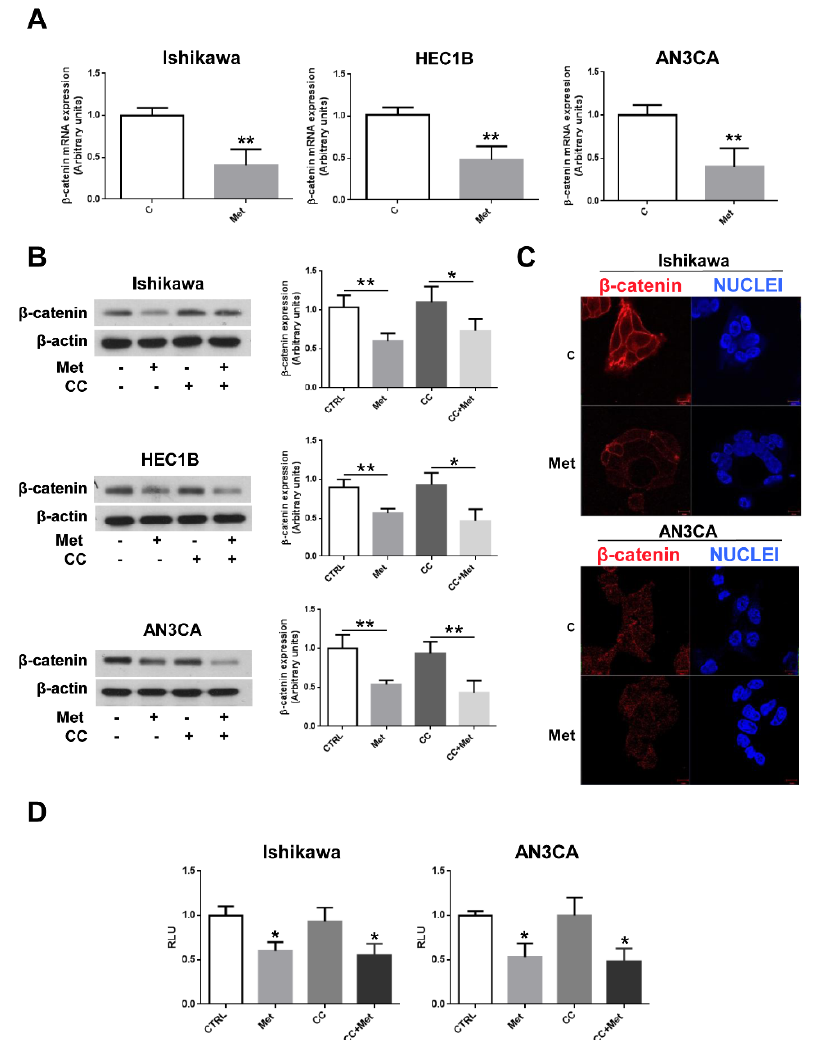
Figure 5. Metformin inhibits β -catenin expression independently from AMPK activation in endometrial cancer cells. ( A ) Ishikawa, HEC1B, or AN3CA cells were treated or not for 24 h with 5 mM metformin. Total RNA was extracted and real-time RT-PCR experiments were performed using oligonucleotides specific to β -catenin and GAPDH as described in the Section 2.4. Values shown represent the mean ( ± s.d.) of triplicate samples of three independent experiments. ** p < 0.05. ( B ) Ishikawa, HEC1B, or AN3CA cells were treated or not for 24 h with 5 mM metformin in the presence or absence of 1 h pretreatment with 10 µ M CC. Total cellular proteins were extracted and Western blot experiments were performed with antibodies against β -catenin or β -actin (loading control), as described in the Section 2.3. Values shown represent the mean ( ± s.d.) of three independent experiments. * p < 0.1; ** p < 0.05. ( C ) Ishikawa and AN3CA cells were grown on glass coverslips for 48 h, then were treated or not for 24 h with 5 mM metformin. Cells were fixed in 4% paraformaldehyde in PBS for 20 min, washed twice in 50 mm NH4Cl in PBS, and permeabilized for 5 min in 0.1% Triton X-100 in PBS. Cells were double-stained with anti- β -catenin antibodies and HOECHST 33258 (Nuclei). Bars, 10 µ m. ( D ) Ishikawa and AN3CA cells were plated in six-well plates to approximately 80% confluence 24 h before transfection. Cells were then transfected with 1.0 µ g of the reporter vector BAT-LUX TCF/LEF and 50 ng of pRL-TK vector with Lipofectamine 3000. After 24 h, transfection medium was replaced with fresh medium and cells were treated or not for 24 h with 5 mM metformin, 10 µ M CC, or pretreated for 1 h with 10 µ M CC followed by treatment with 5 mM metformin. Firefly and renilla activities were determined in cell lysates using the Dual-Luciferase Reporter Assay System and a luminometer. Results were expressed as the ratio of firefly to renilla activity. Values shown represent the mean ( ± s.d.) of triplicate samples of three independent experiments. * p <